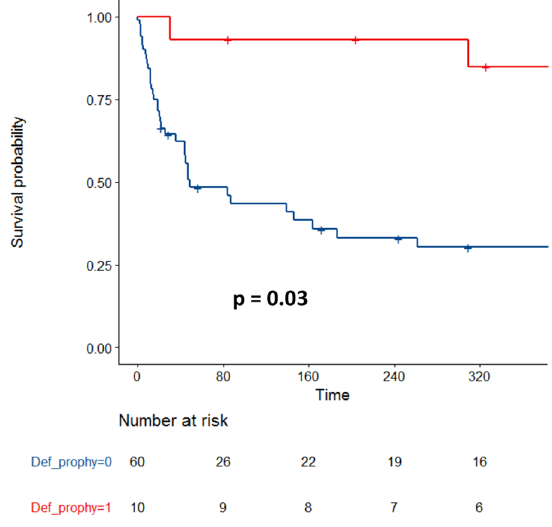
Fig. 1 Survival curve according to defibrotide treatment after adjust‑ ment of confounding factors P‑080 Etiology and outcome of acute respiratory failure in critically Ill immunocompromised and neutropenia: Retrospective analysis of a prospective multicenter multinational dataset Djamel Mokart 1 , Michaël Darmon 2 , Achille Kouatchet 3 , Massimo Antonelli 4 ,